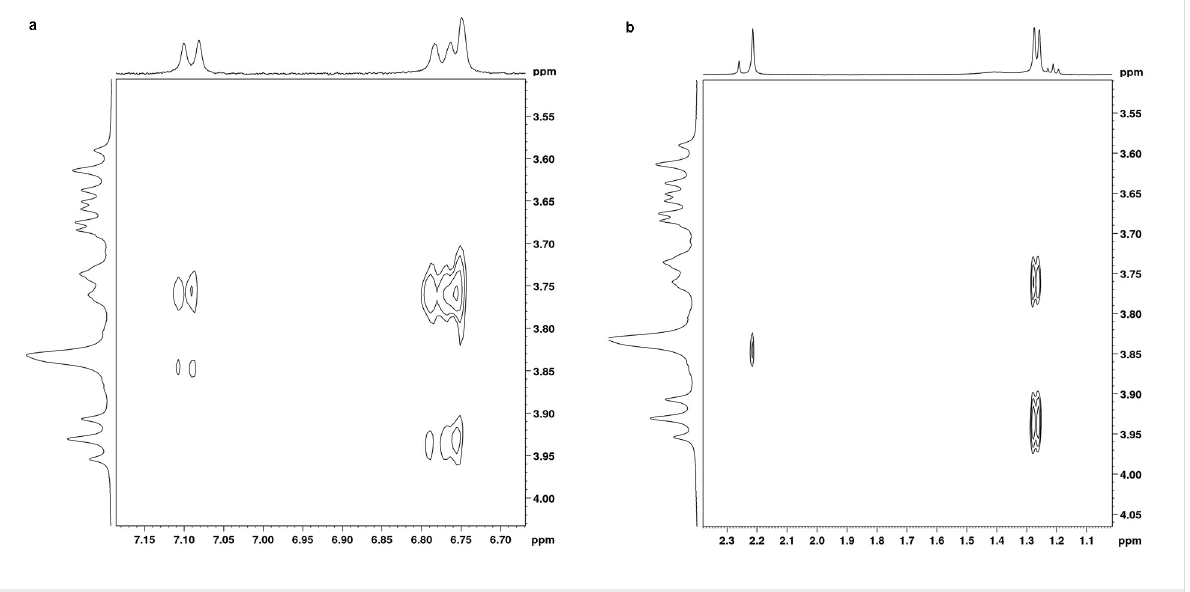
Figure 5: 2D ROESY plots of β -CD/carvacrol ( 1 ) complex in D 2 O showing the NOEs between the H-3 and H-5 protons of β -CD and (a) the aromatic protons and (b) the aliphatic protons of carvacrol ( 1 ).